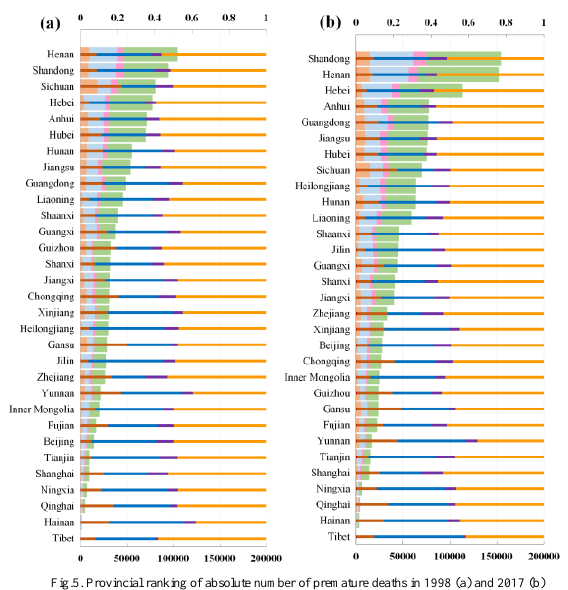
Fig.5. Provincial ranking of absolute number of premature deaths in 1998 (a) and 2017 (b)